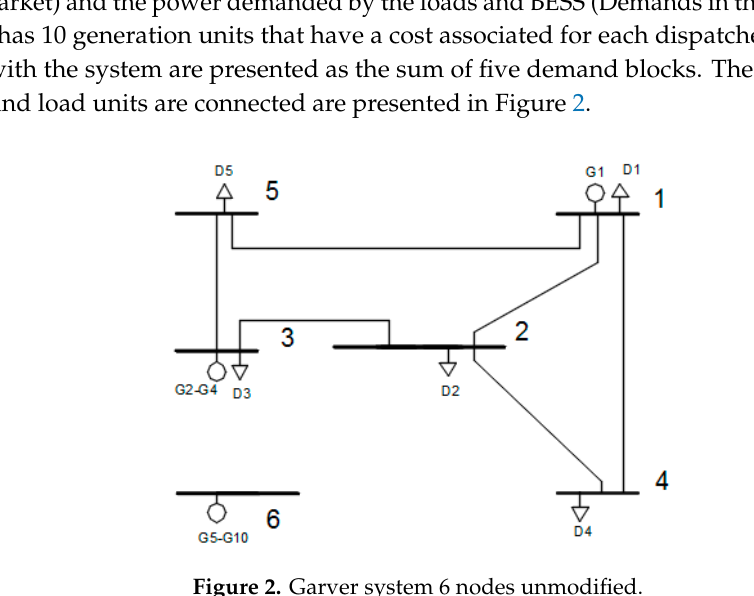
Table 1. Demand and generator restrictions.